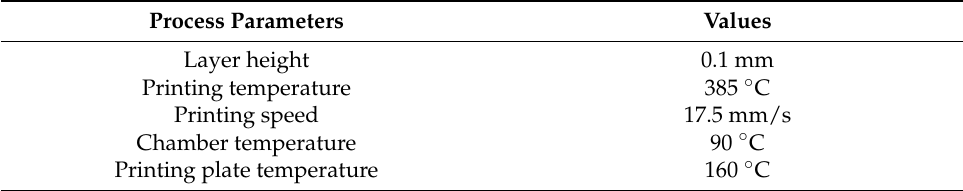
Table 3. Optimized FFF parameters for PEEK-20CF.